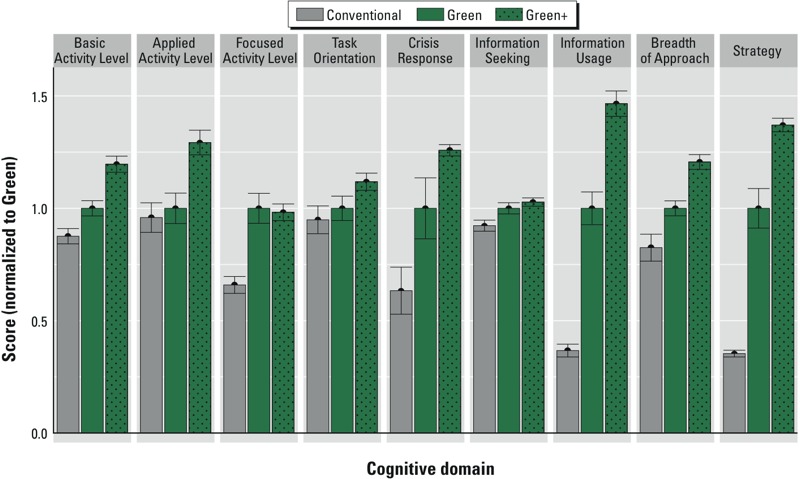
Average cognitive function scores and standard error bars by domain for the Conventional, Green, and two Green+ conditions, normalized to the Green condition by dividing all scores by the average score during the Green condition.